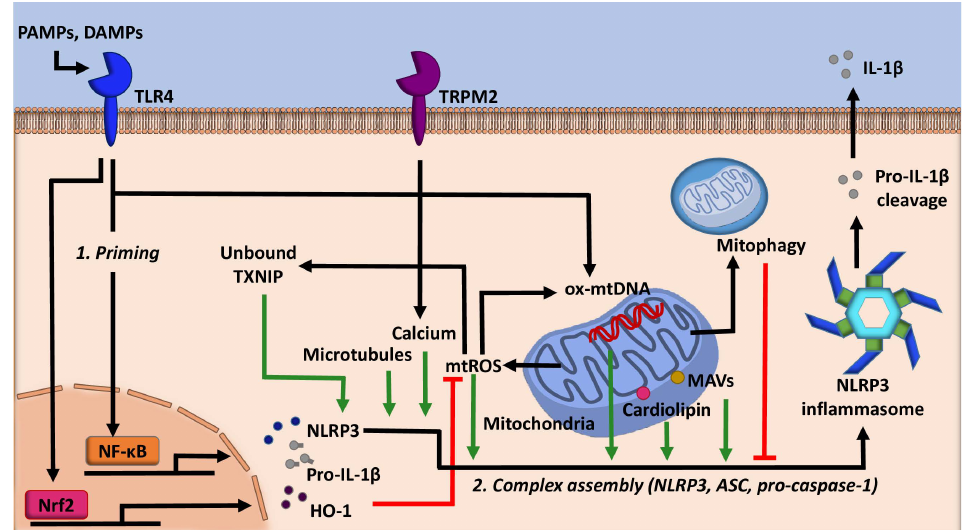
Figure 1. The role of mitochondria in regulating NLRP3 activity. Mitochondria are central in the regulation of the NLRP3 inflammasome. Mitochondrial damage leads to the production of mitochondrial reactive oxygen species (mtROS) and the release of newly synthesized mitochondrial DNA (mtDNA) into the cytosol, which gets oxidized (ox-), both stimulating the activation of the NLRP3 inflammasome. Priming signal activates nuclear factor erythroid 2-related factor 2 (Nrf2) and cellular stress responses such as heme-oxygenase-1 (HO-1), which mitigates the e ff ects of mtROS and inhibit inflammasome activation. Mitophagy inhibits inflammasome activation by destructing pro-IL-1 β and inflammasome complex, attenuating mitochondrial oxidative stress, and reducing mtDNA synthesis. mtROS stimulates thioredoxin-interacting protein (TXNIP) to release thioredoxin. Thioredoxin-free TXNIP then directly binds NLRP3 to enhance its activation. Additionally, microtubules, calcium signaling, cardiolipin, and mitochondrial antiviral-signaling protein (MAVs) aid in the assembly of NLRP3 inflammasome complex on the mitochondria, enhancing its activity. Green lines denote the promotion of NLRP3 activity, whereas red lines denote the inhibition of NLRP3 inflammasome activity. ASC: apoptosis-associated speck-like protein, DAMPs: danger-associated molecular patterns, PAMPs: pathogen-associated molecular patterns, TLR4: Toll-like receptor 4, and TRPM2: transient receptor potential melastatin 2.